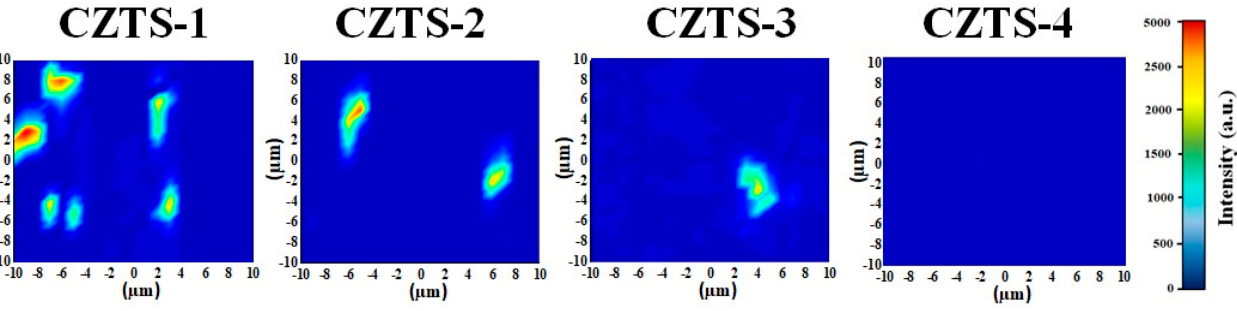
each specimen. Figure 4 shows Raman mapping images of CZTS − 1, CZTS − 2, CZTS − 3,